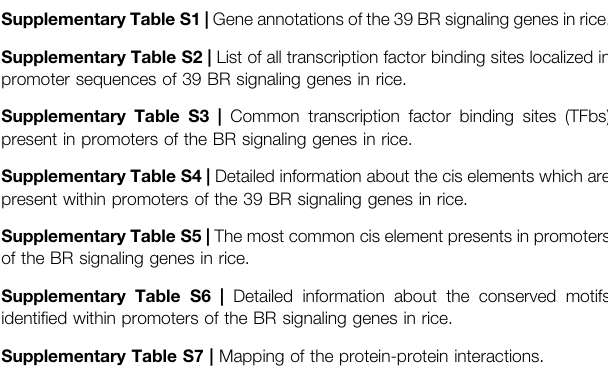
Supplementary Figure S1 | Structure of the BR-signaling genes: blue boxes represent the untranslated regions, yellow boxes represent exons, and black connecting lines represent introns. Supplementary Table S1 | Gene annotations of the 39 BR signaling genes in rice.